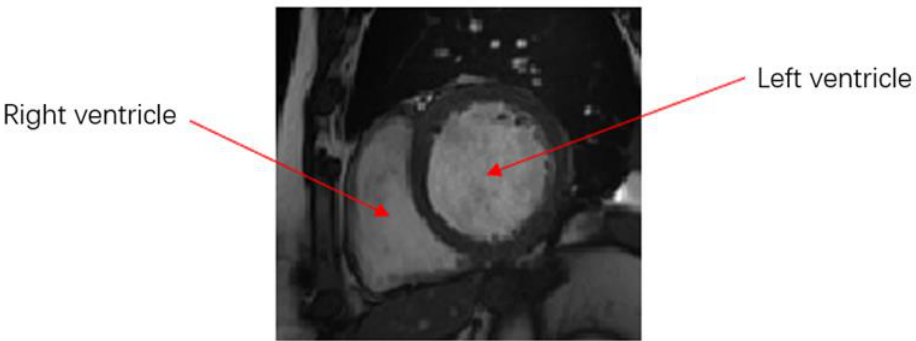
Figure 1. MR image of the heart.